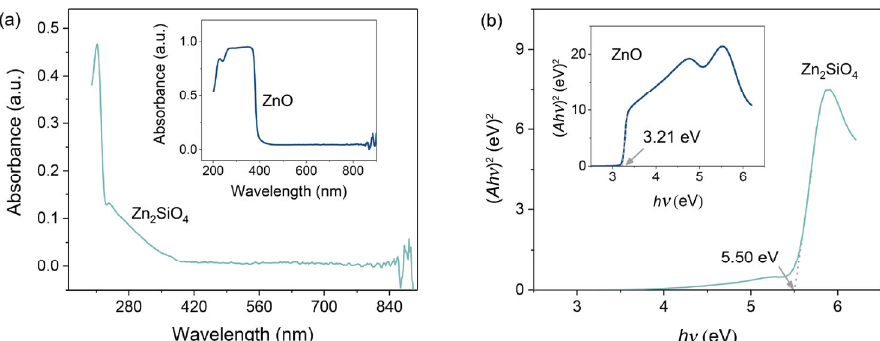
Fig. 4 Optical properties of Zn 2 SiO 4 and ZnO. (a) Diffuse reflectance UV–Vis spectra and (b) plots of ( ) Ah  2 vs. h  . “ A ” in the Y -axis title represents the absorbance, h represents the Planck constant, and  represents the frequency. 3.